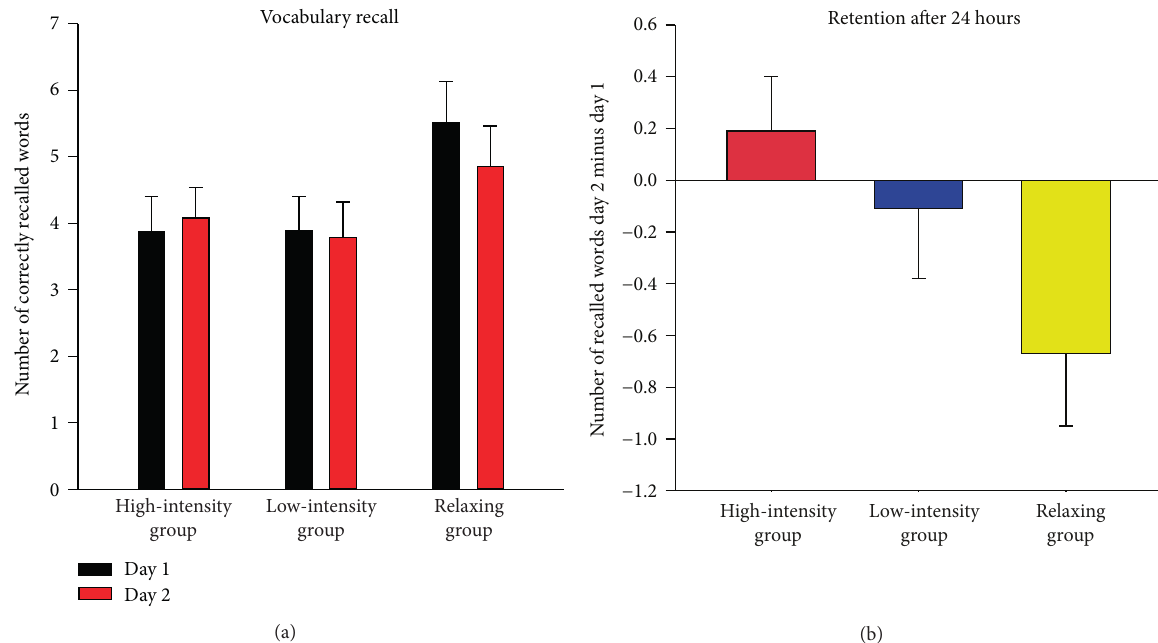
Figure 2: Memory for newly learned vocabulary. (a) Mean number of correctly recalled words at day one (60 minutes after learning) and at day two (24h after learning), separately for the high-intensity group, the low-intensity group, and the relaxing group. (b) Retention after 24 hours, defined as the difference between numbers of correctly recalled words at day one minus day two. Error bars depict ± 1 standard error of the